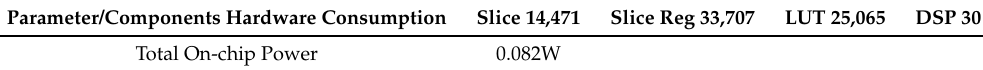
Table 2. Implementation Overhead of the device parameter verification unit presented in Figure